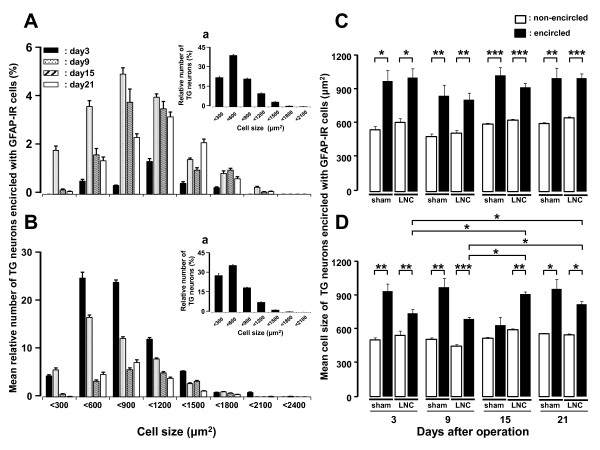
Change in GFAP expression in TG after LNC. Time-course changes are shown in the cell size of somata of TG neurons encircled with GFAP-IR cells on day 3, 9, 15 and 21 after LNC and sham operation in V1/V2 branch regions (A and C) and V3 branch region (B and D). Size-frequency histogram illustrating distribution of sotama of TG neurons encircled with GFAP-IR cells in V1/V2 branch regions (A) and V3 branch region (B) on days 3, 9, 15 and 21 after LNC. Size-frequency histograms illustrating distribution of somata of TG neurons in V1/V2 branch regions (Aa) and V3 branch region (Ba) in naïve rats, respectively. *: p <0.05, **: p <0.01, ***: p < 0.001 (n = 5 in each group, Student's t-test, one-way ANOVA followed by Newman-keuls tests).